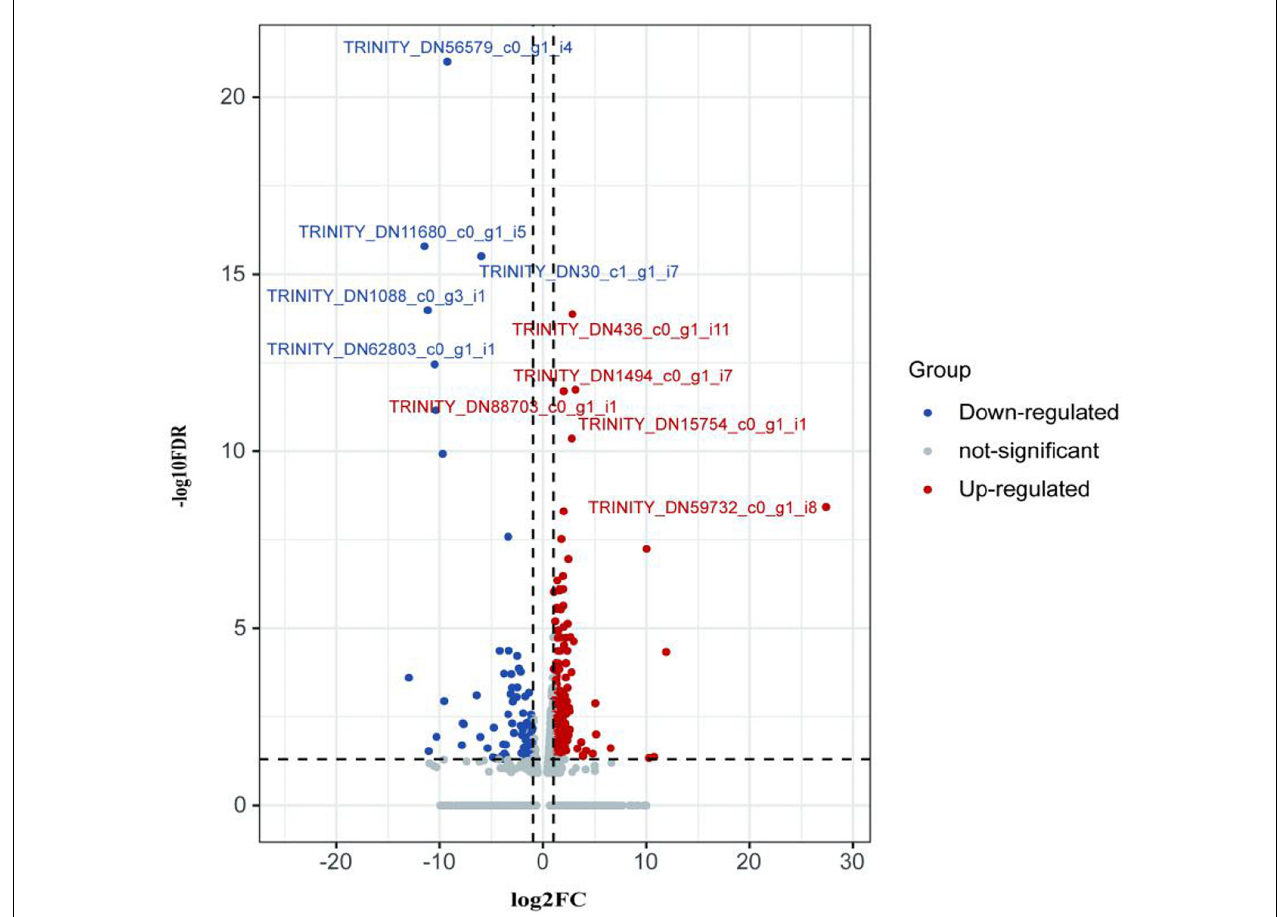
FIGURE 4 | Volcano plot obtained from the DESeq2 analysis of Epinephelus coioides ’s spleen RNA pools (3 dpi).